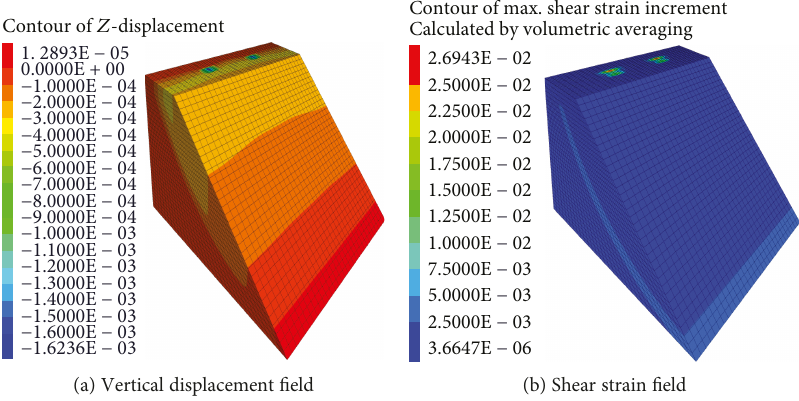
Figure 21: Vertical displacement fi eld and shear strain fi eld after loading of 50kg.